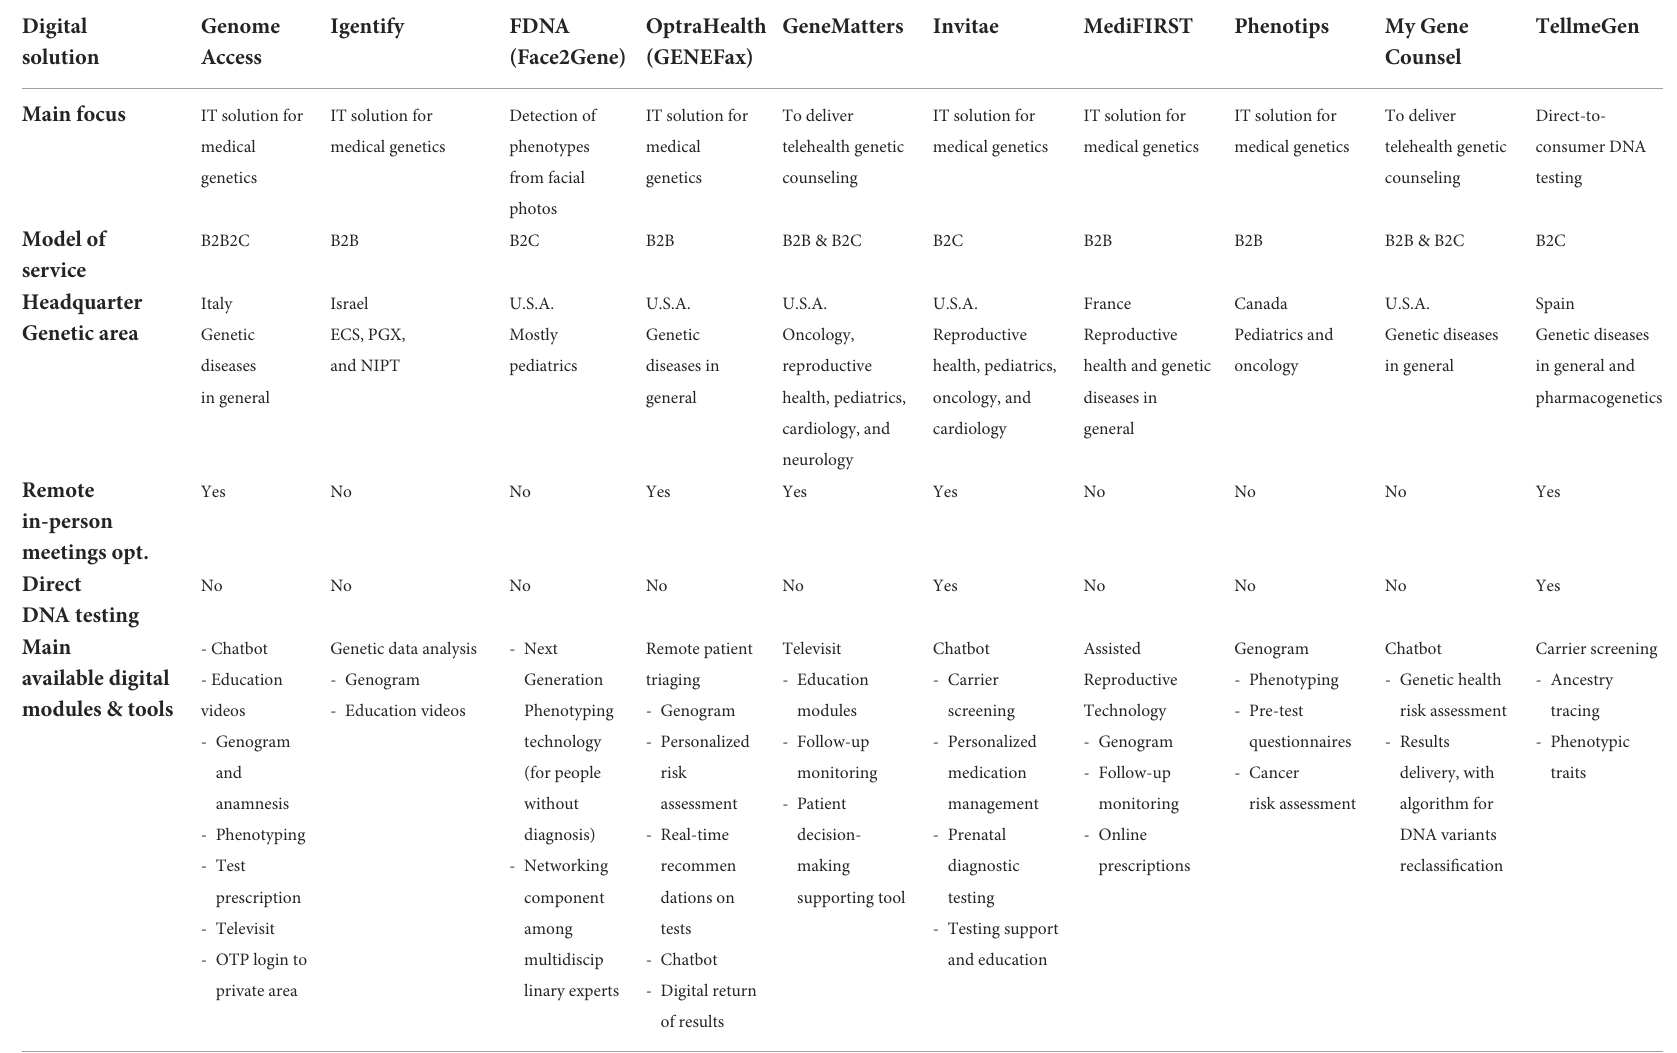
TABLE 1 Digital genetic platforms